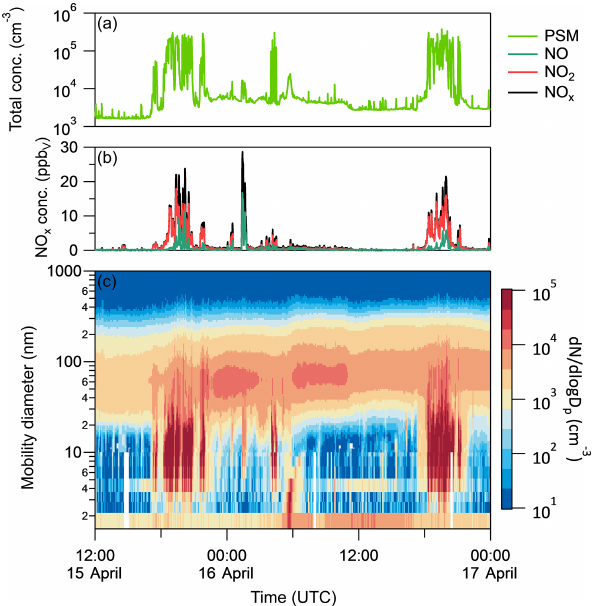
Figure 6. Time series of the particle size distribution from 1 to 1000nm (c) during airport emission plumes. Panel (a) shows the 1min averaged time series of the total particle concentration mea- sured by the Airmodus A10 PSM on a logarithmic scale. Trace gases (NO, NO 2 , NO x = NO + NO 2 ) are shown in panel (b) . Air- port emissions can clearly be assigned to the plumes of nucleation mode particles being carried to the station during N-NW wind sit- uations (wind not shown here). The particle plumes with maximum particle concentrations of 3 × 10 5 cm − 3 (a) are accompanied by el- evated NO and NO 2 levels (b) . On 16 April, a new mode appears in the sub-10nm size range showing well the different behaviour between emission plumes and NPF.